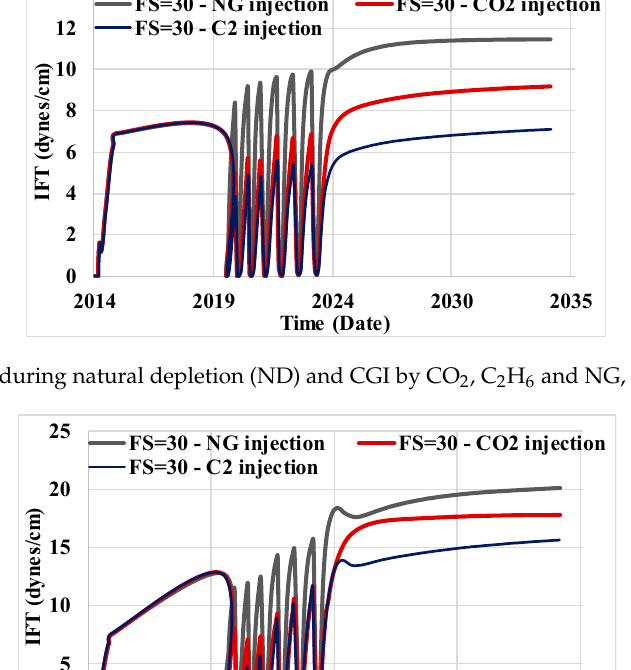
Figure 8. IFT during natural depletion (ND) and CGI by CO 2 , C 2 H 6 and NG, Oil API=31°.